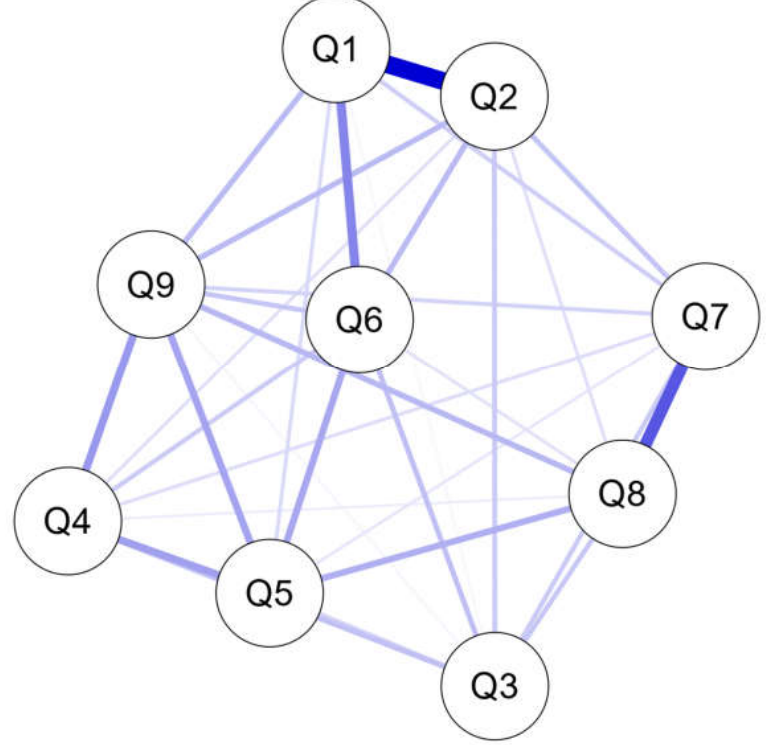
Figure 1. Network plots of depressive symptoms. Edge thickness indicated the strength of the par-